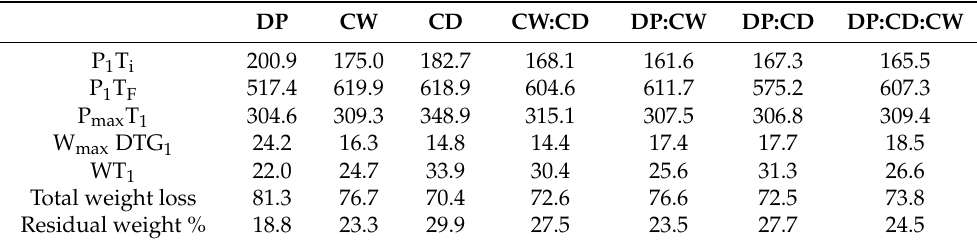
Table 2. Thermal degradation behavior of single, binary, and ternary resulting in significant weight